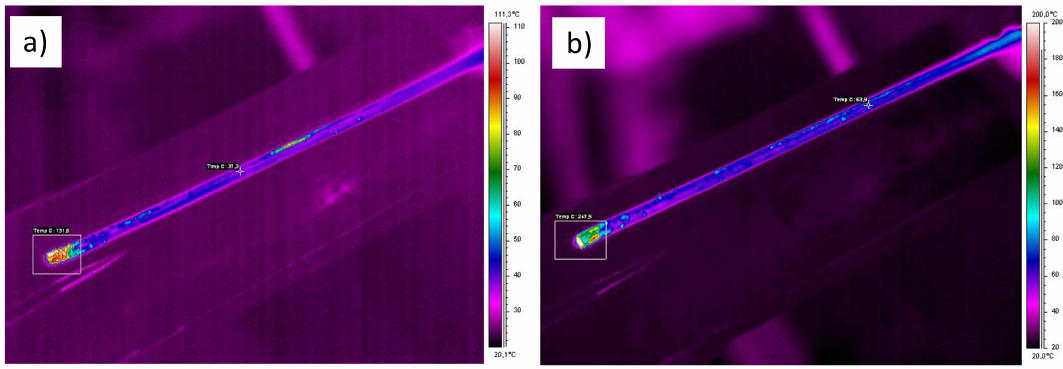
Figure 3. Thermographical pictures of surface samples of Al–Cu alloys after extrusion combined with reversible torsion (KoBo) processing with λ = 98: ( a ) Al 5 Cu alloy, ( b ) Al 25 Cu